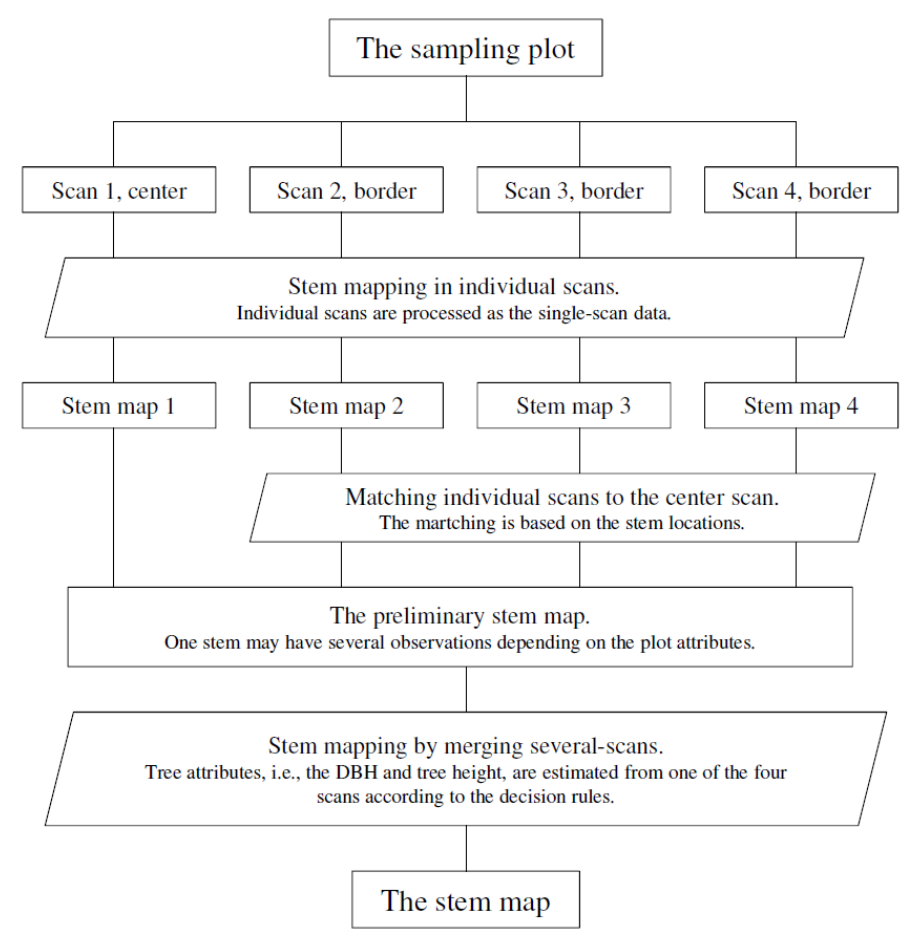
Figure 4. Conceptual diagram of the MSS